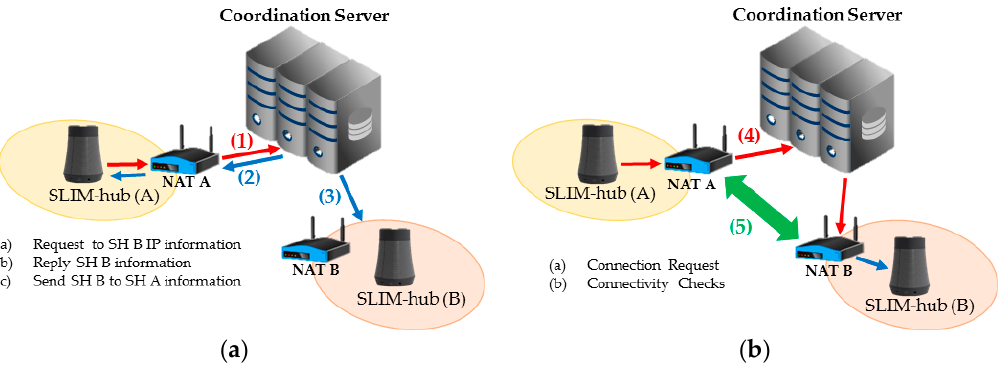
Figure 10. Connection process between the SLIM hubs in a private network. ( a ) Request IP information from another SLIM hub; ( b ) Connection request and connectivity checks.